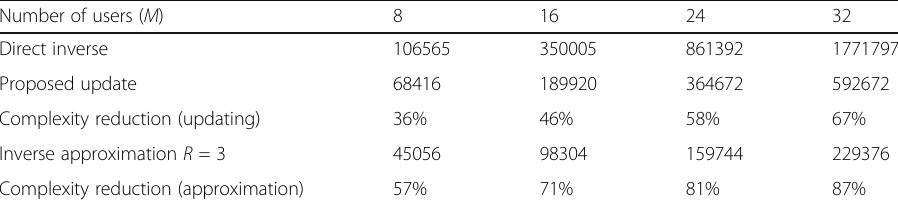
Table 4 Numbers of complex-valued operations required for the ZF STBC decoder: new channel estimation for a user